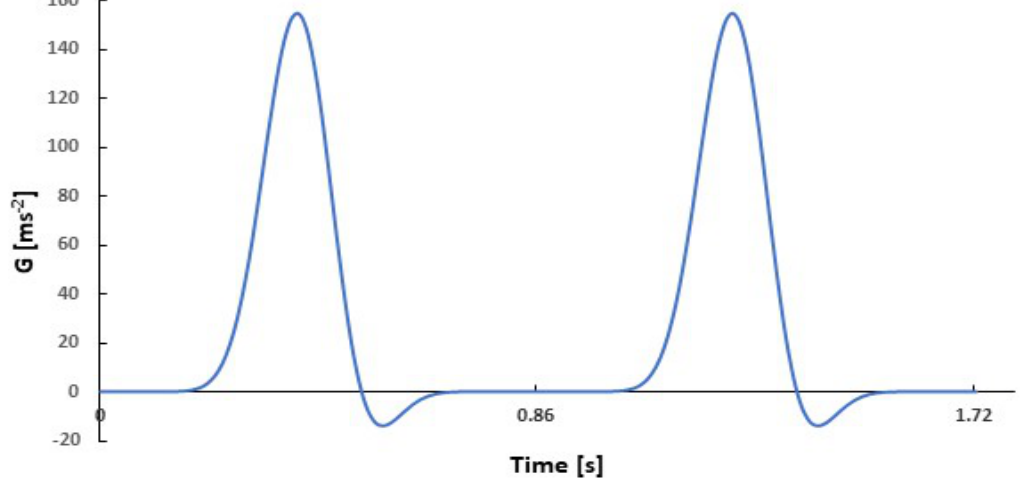
Figure 2. Pulsatile flow function.